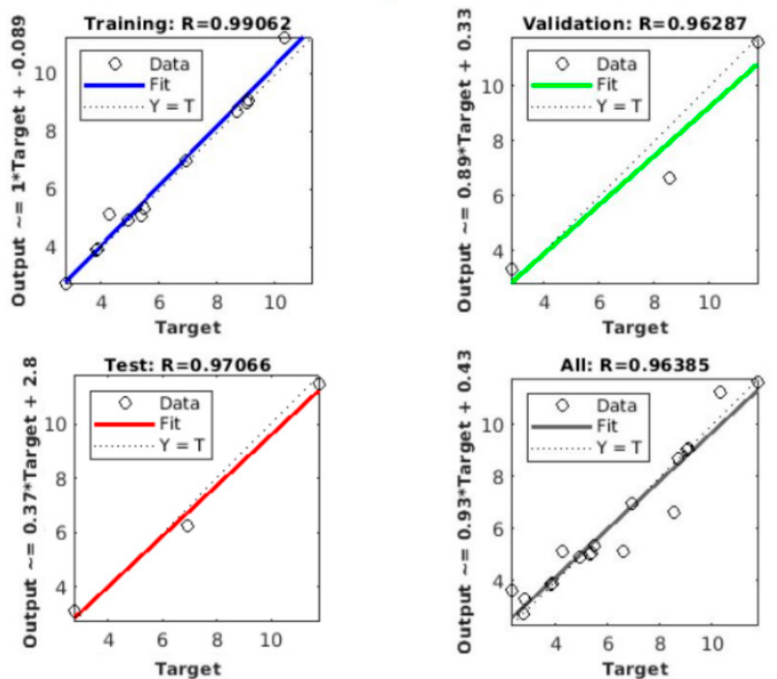
Figure 26 . Regression plots for training, validation, and testing of the ANN model.